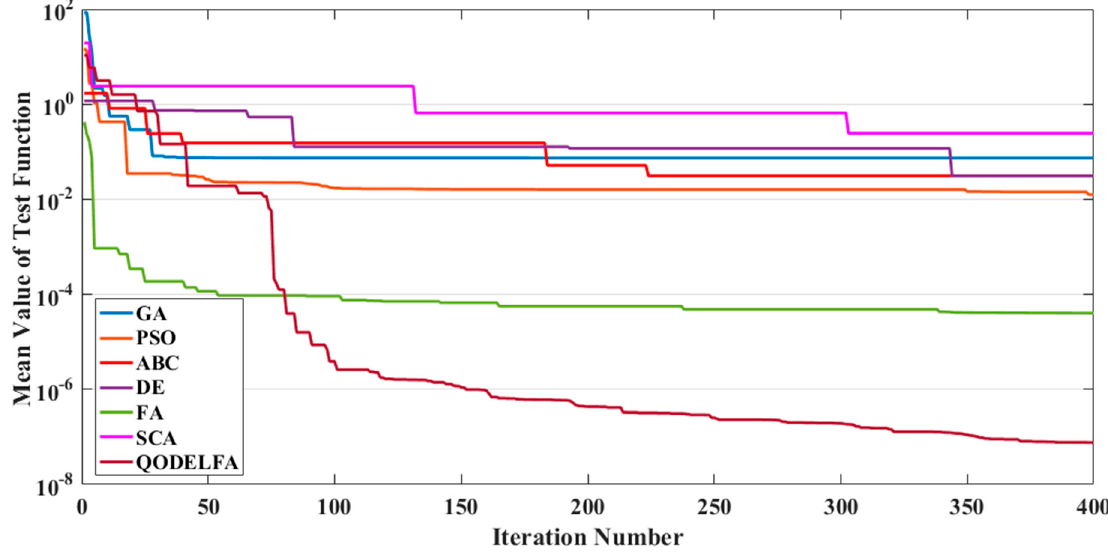
Figure 4. Convergence characteristics for the power sum function.